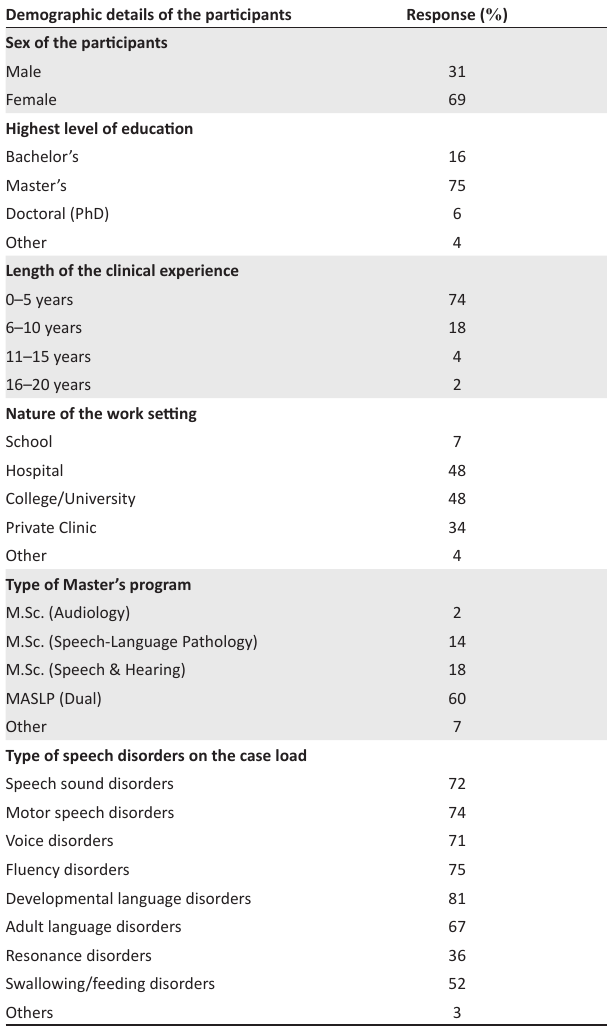
TABLE 1: Demographic details of the